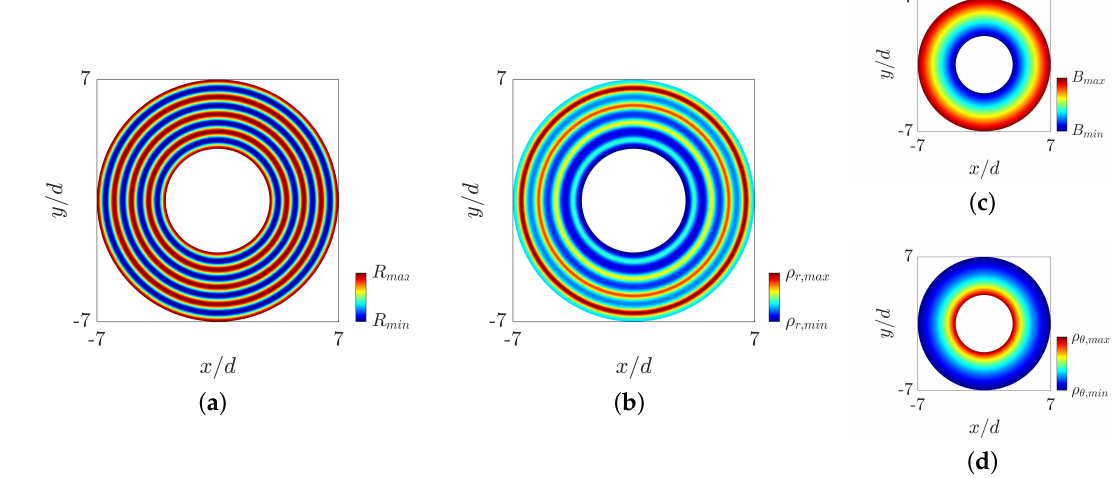
Figure 2. Schematic of the spatial modulation. ( a ) Graphical representation of R ( r , θ ) . ( b ) Radial density distribution ρ r ( r , θ ) in space. ( c ) Representation of the bulk modulus B ( r , θ ) in the plane. ( d ) Tangential density ρ θ ( r , θ ) distribution in space. ρ θ ( r , θ ) is inversely proportional to the radius, whereas B ( r , θ ) is linearly increasing with r .